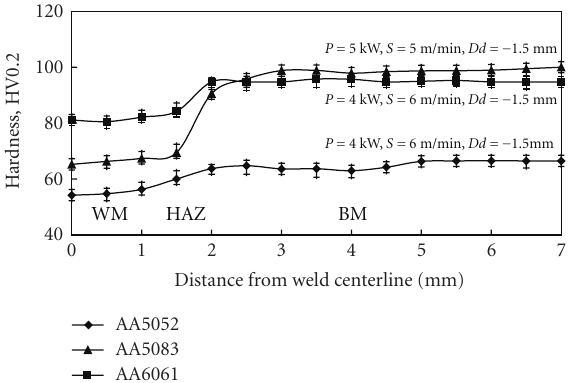
Figure 12: Hardness profiles through weld metal, HAZ, and base metal f both AA5000 and AA6000 series